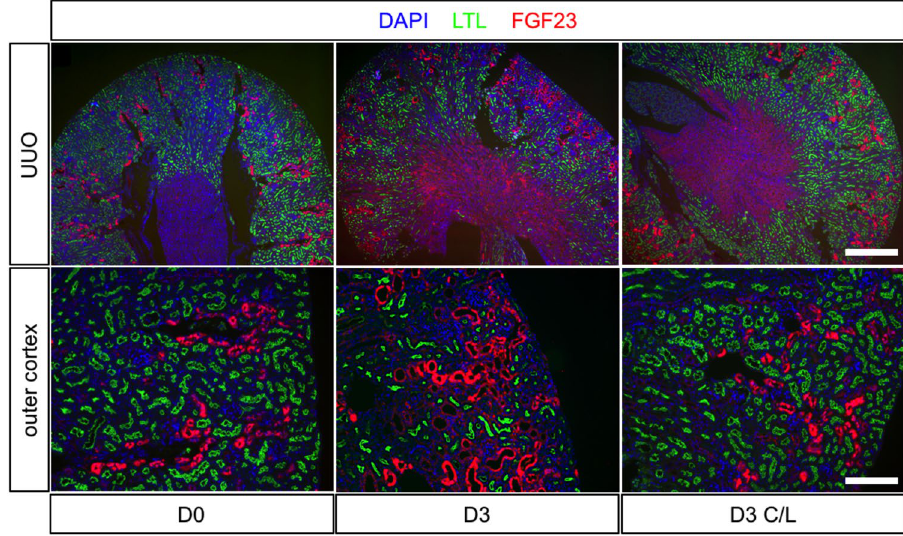
Figure 2. Renal localisation of FGF23 before and after UUO. Representative immunofluorescent staining of FGF23 (red), a proximal tubule marker LTL (green), and the nuclear marker DAPI (blue) in D0, D3 OB and D3 C/L kidney sections. Lower panel shows enlarged region of the outer cortex from corresponding micrographs above. Scale bar upper panel = 250 μ m; lower panel = 100 μ